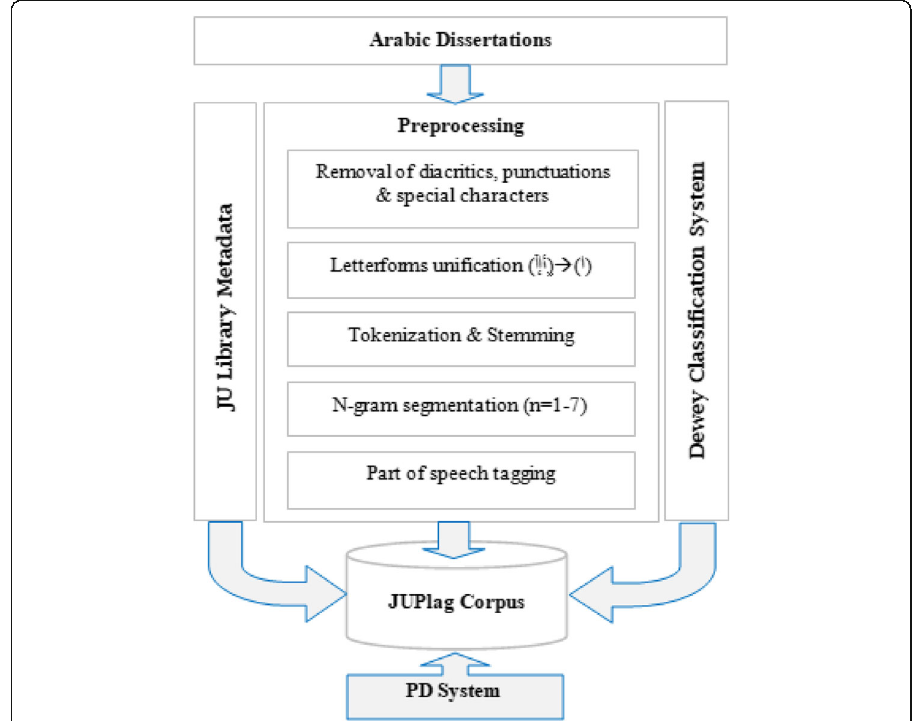
Fig. 2 Processing outline of the JUPLag